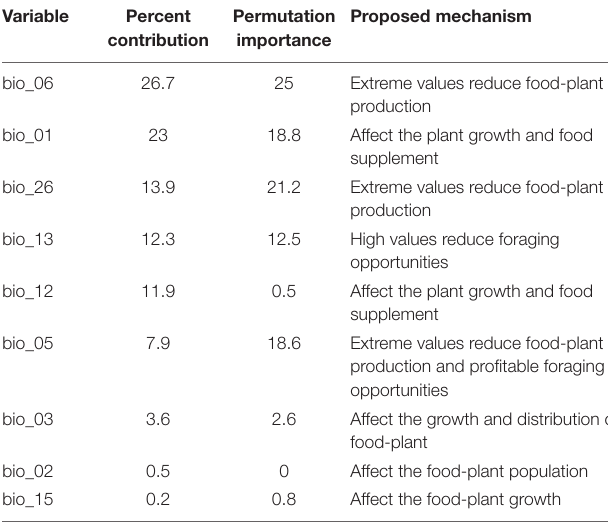
TABLE 1 | Percent contributions and permutation importance of the bioclimatic/environmental variables.